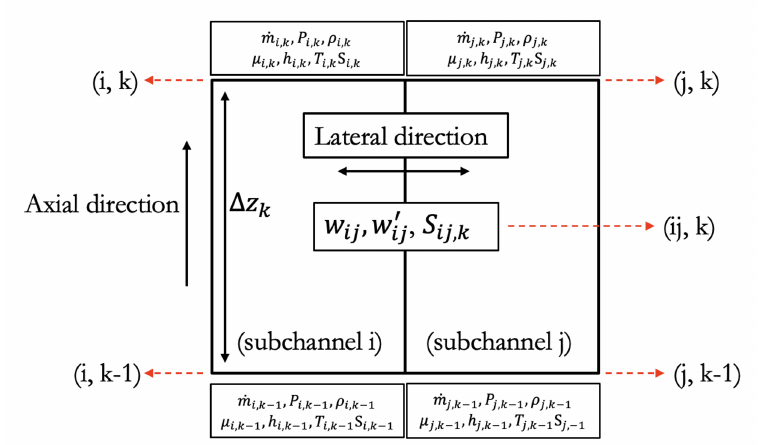
Figure 2. Subchannel collocated